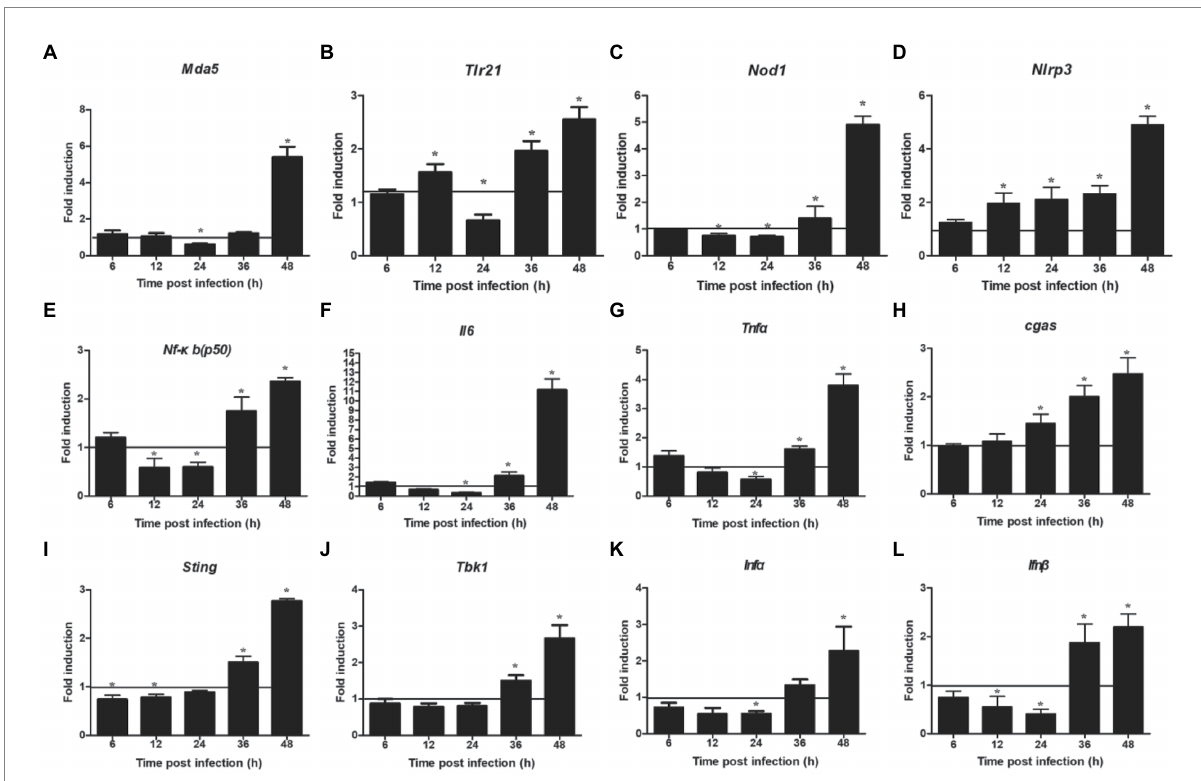
FIGURE 5 Expression levels of inflammatory and immune related factors. (A) Mda 5 , (B) trl 21 , (C) nod 1 , (D) nlrp 3 , (E) nf- κ b(p50) , (F) il 6 , (G) tnf α , (H) cgas , (I) tbk 1 , (J) sting, (K) ifn α , (L) ifn β . Relative expression is normalized to β -actin . Fold induction as compared to mock-infected samples, the solid line is representative of 1 fold for mock samples. Data are shown as mean (SD) with n = 3 per group. * p <